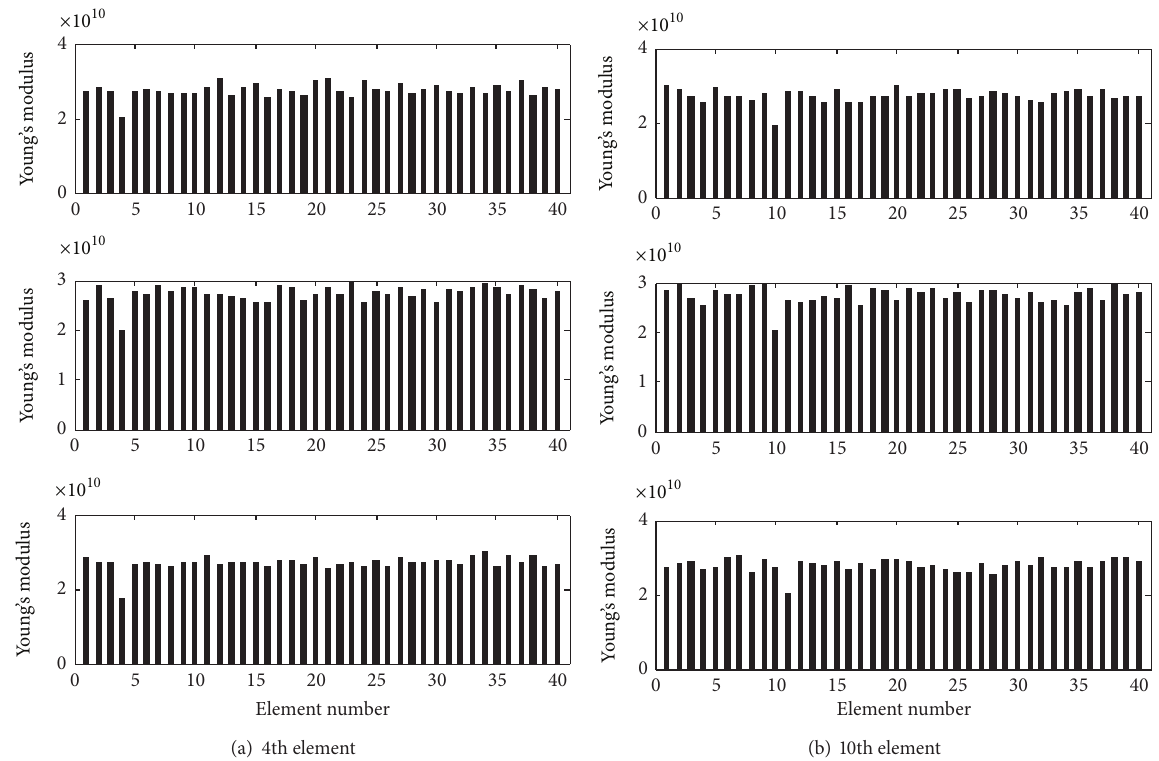
Figure 5: Identified equivalent Young’s modulus from first part for damage at (a) fourth element and (b) tenth element.